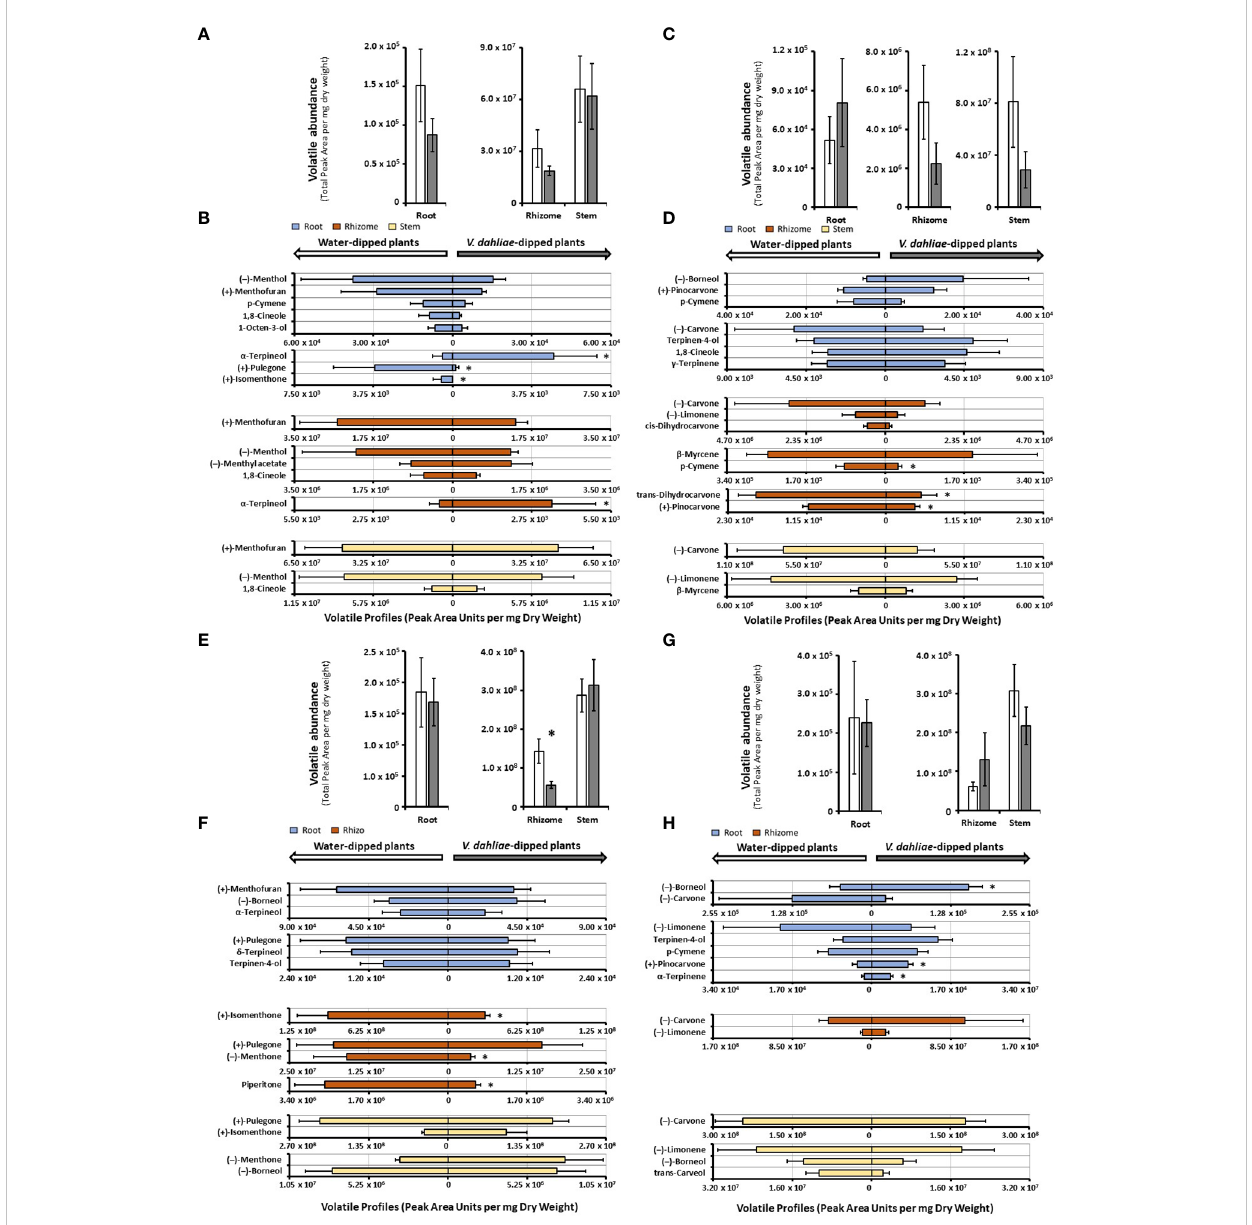
FIGURE 3 Monoterpenoid volatile pro fi les, as determined by SPME – GC – MS analysis, released by several organs of mint species maintained in growth chambers and prepared for V. dahliae inoculation (columns represent means of 4 – 6 biological replicates, with bars showing the standard error of the mean). The total volatile abundance of volatiles emitted by each organ is shown in panels (A) (peppermint), (C) (spearmint), (E) (M. longifolia CMEN 585), and (G) (M. longifolia CMEN 584, with white columns for controls and gray columns for experimental samples. The left panel of each butter fl y diagram shows data for mock-inoculated controls, while the right panel has data for plants whose roots were inoculated with V. dahliae , with (B) , peppermint; (D) , spearmint; (F) , M. longifolia CMEN 585; and (H) , M. longifolia CMEN 584. The color code of columns is as follows: yellow, stems; orange, rhizomes; and blue, roots. An asterisk represent P -value <